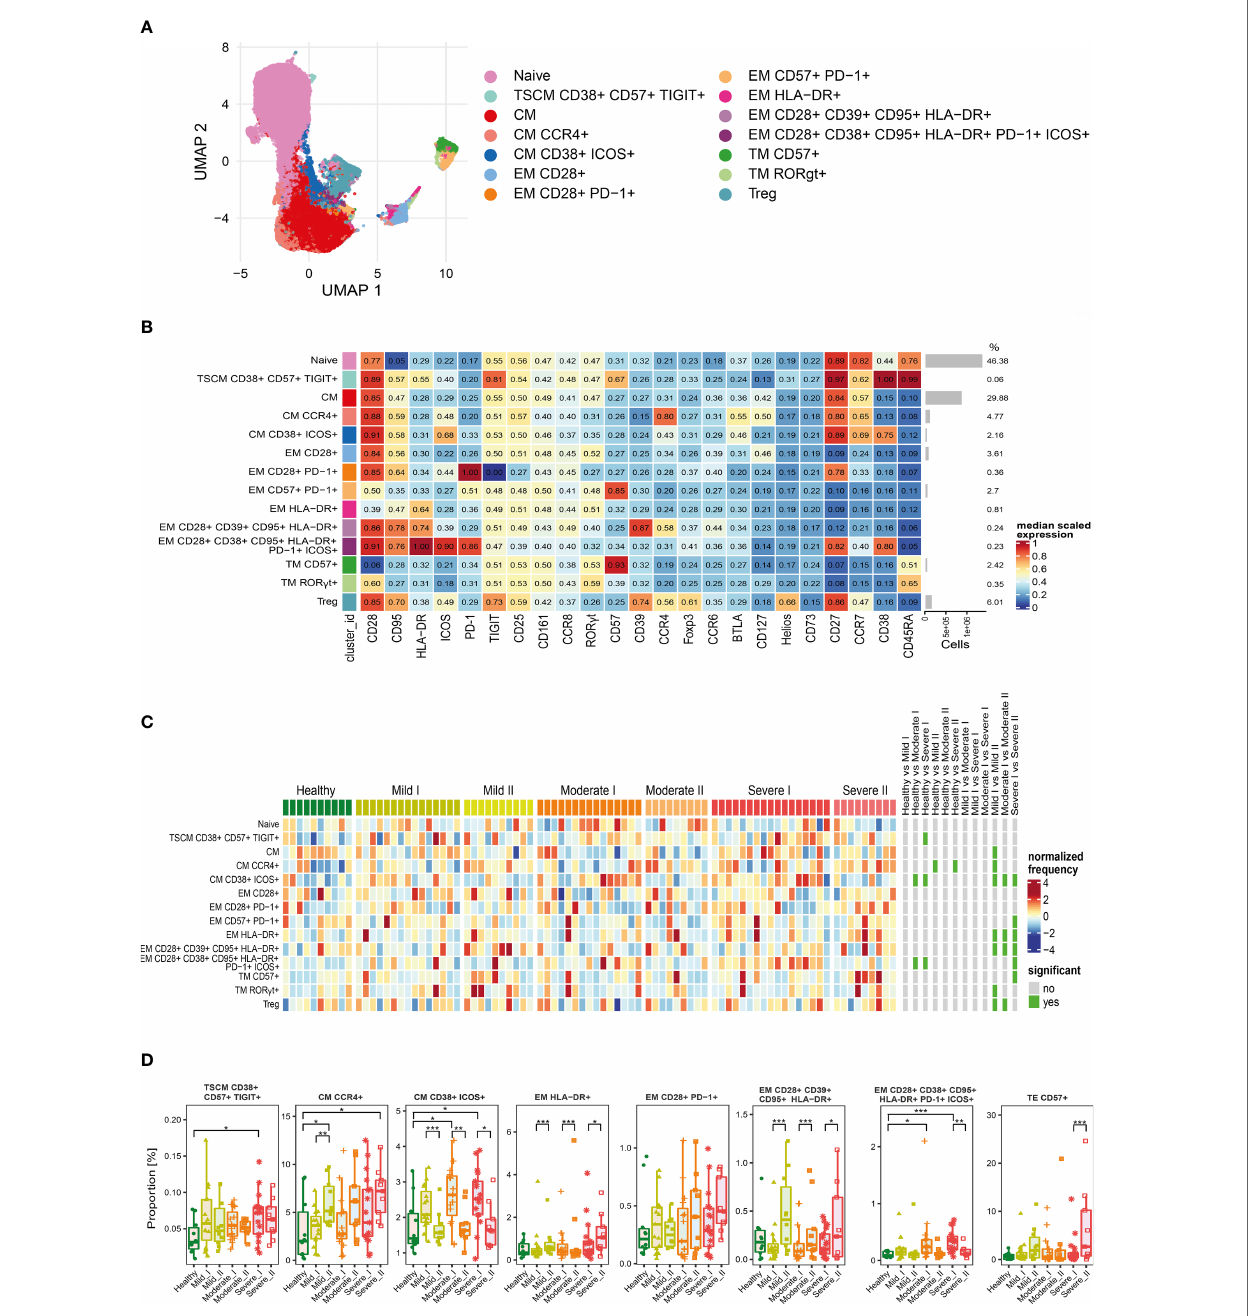
FIGURE 3 | Unsupervised analysis of CD4+ T cells and their characterization. (A) Uniform Manifold Approximation and Projection (UMAP) UMAP representation of CD4+ T cell landscape. (B) Heat map representing different clusters identi fi ed by FlowSOM, with relative identity and percentages in healthy controls and convalescent patients. The color in the heat map represents the median of the arcsinh, 0 – 1 transformed marker expression calculated over cells from all the samples, varying from blue for lower expression to red for higher expression. Each cluster has a unique color assigned (bar on the left). Barplots along the rows (clusters) and values on the right indicate the relative sizes of clusters. (C) Differential analysis of all severity groups of COVID-19 convalescent patients (mild, moderate, severe), as well as healthy donors at the time points I and II. The heat represents arcsine-square-root transformed cell frequencies that were subsequently normalized per cluster (rows) to mean zero and standard deviation of one. The color of the heat varies from dark blue indicating relative under- representation to red indicating relative over-representation. Bars at the right indicate signi fi cantly differentially abundant clusters (green). (D) Differential proportion of selected clusters presented as % of CD4+ cells. *p ≤ 0,05; **p ≤ 0,01; ***p ≤